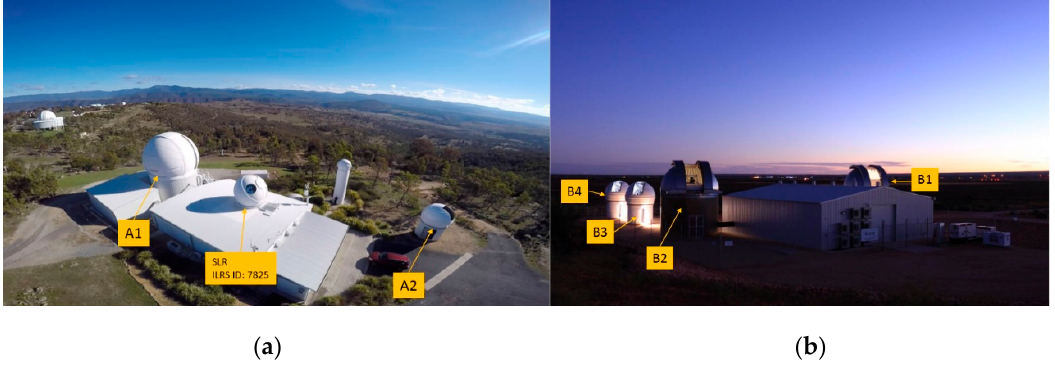
Figure 2. The image of two tracking sites. ( a ) Mt. Stromlo site; ( b ) Learmonth site [15].